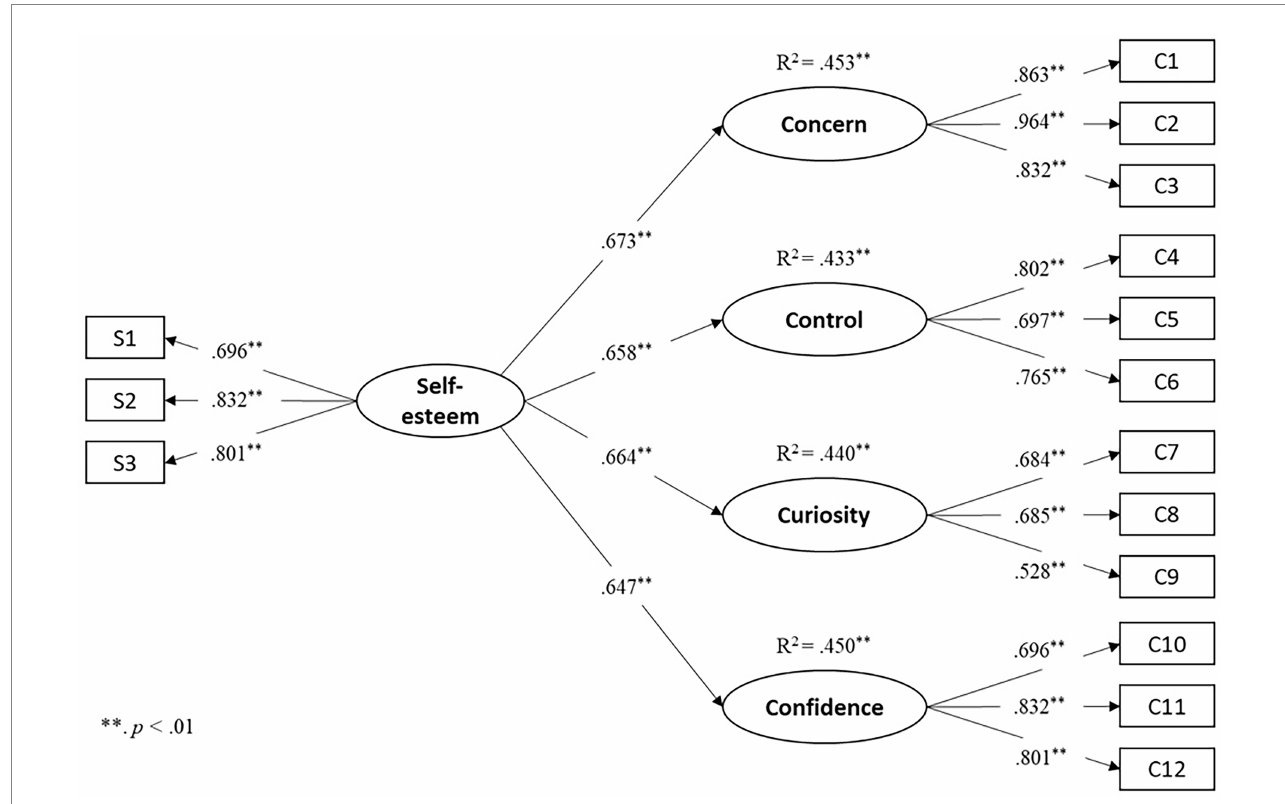
FIGURE 2 The SEM model with self-esteem as an independent variable and the four CASS dimensions as dependent variables (standardize